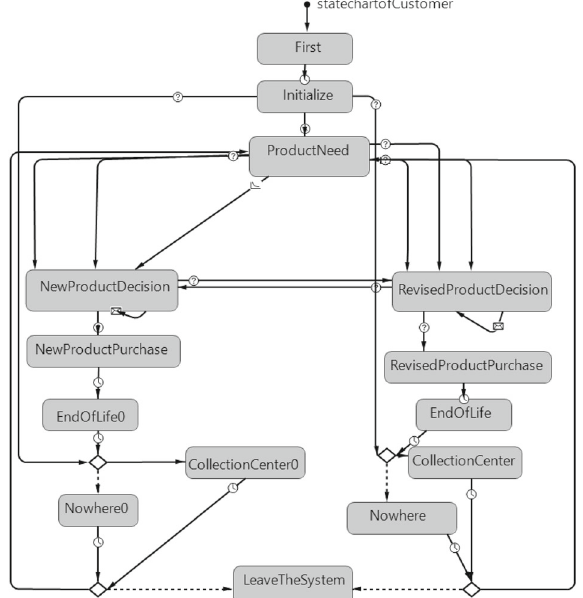
Fig. 4 Statechart of customer agent